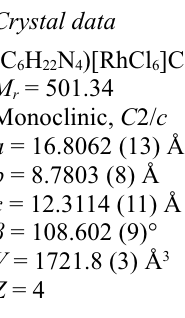
Figure 3 Part of the distorted face centered cubic packing of [RhCl holes; note the relationship to the simple sodium chloride structure if the anions would be treated as pseudo spheres. Triethylenetetrammonium hexachloridorhodate(III) chloride Crystal